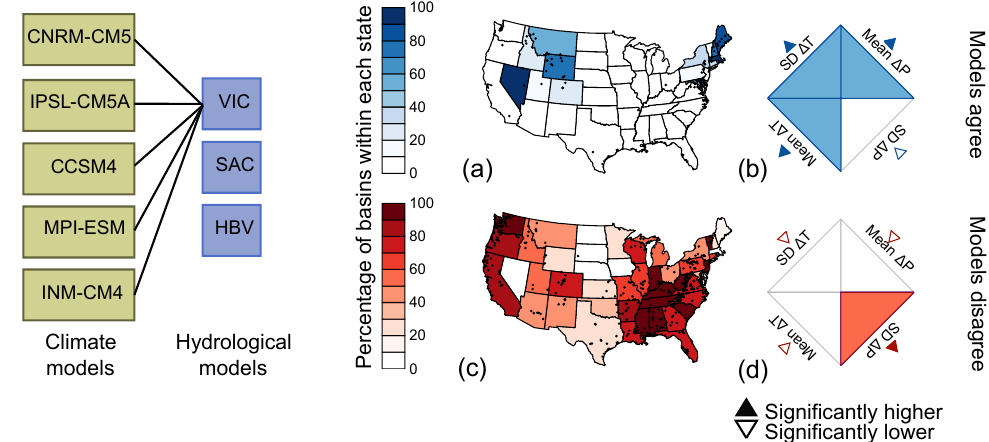
Figure 7. Spatial distribution of the basins in which Variable Infiltration Capacity model (VIC) simulations driven by the five climate models fully agree on the sign of change in mean annual runoff (a) and disagree on the sign of change (c) . The rose plots (b, d) show standardized climate change characteristics for catchments shown in (a) and (c) , respectively. The “SD (cid:49)T ” ( P ) stands for the standard deviation of the projected change in temperature (precipitation) for the five different climate models; “mean (cid:49)T ” ( P ) is the mean projected change in temperature (precipitation) of the five different climate models. The characteristics in the rose plots have been standardized from 0 to 1, where 0 represents the lowest value of the characteristics for the two displayed groups, and 1 the highest value of the characteristics for the two displayed groups. Left panel: combination of climate model and hydrologic model (VIC: Variable Infiltration Capacity model; SAC: Sacramento Soil Moisture Accounting model; HBV: Hydrologiska Byråns Vattenbalansavdelning model) for which the results are